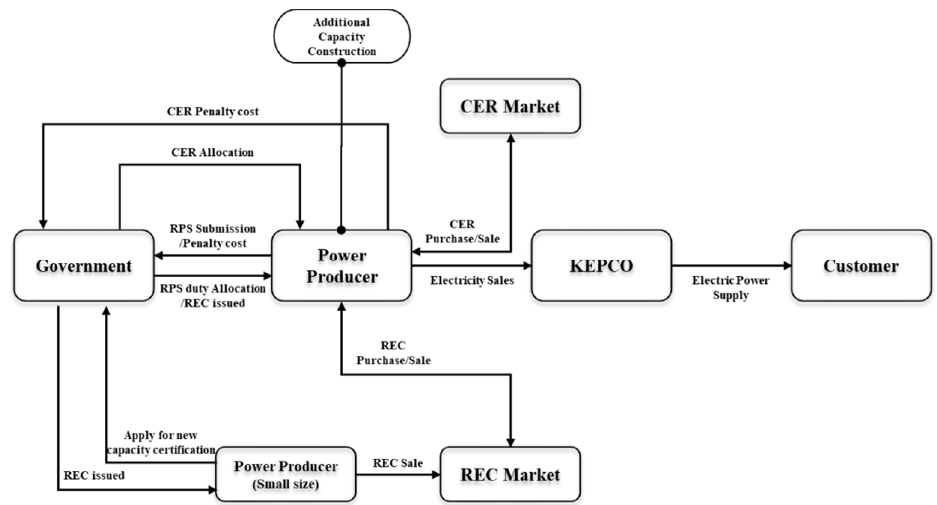
Figure 3. Integrated operational scheme for Korean power producers.